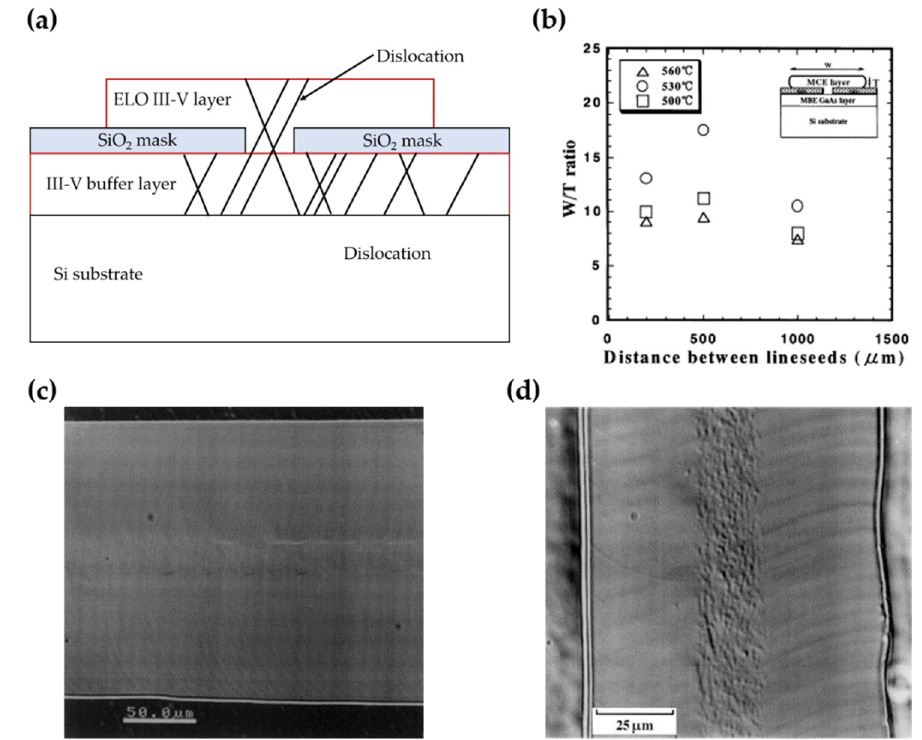
Figure 12. ( a ) A schematic illustration of the epitaxial lateral overgrowth (ELO). ( b ) Dependence of width to the thickness (W/T) ratio on the growth temperatures and the line separation of the opened mask. ( c ) Optical microphotograph of the surface of ELO GaAs layer after 7 h growth. The width and thickness of the layer are 195 and 12 μ m, respectively. ( d ) Optical microphotography of the ELO GaAs layer after KOH wet etching. The width of the etch-pit-free laterally grown region is 43 μ m. (b)~(d): Reprinted with permission from Reference [179] © 1998 Elsevier Science B.V.